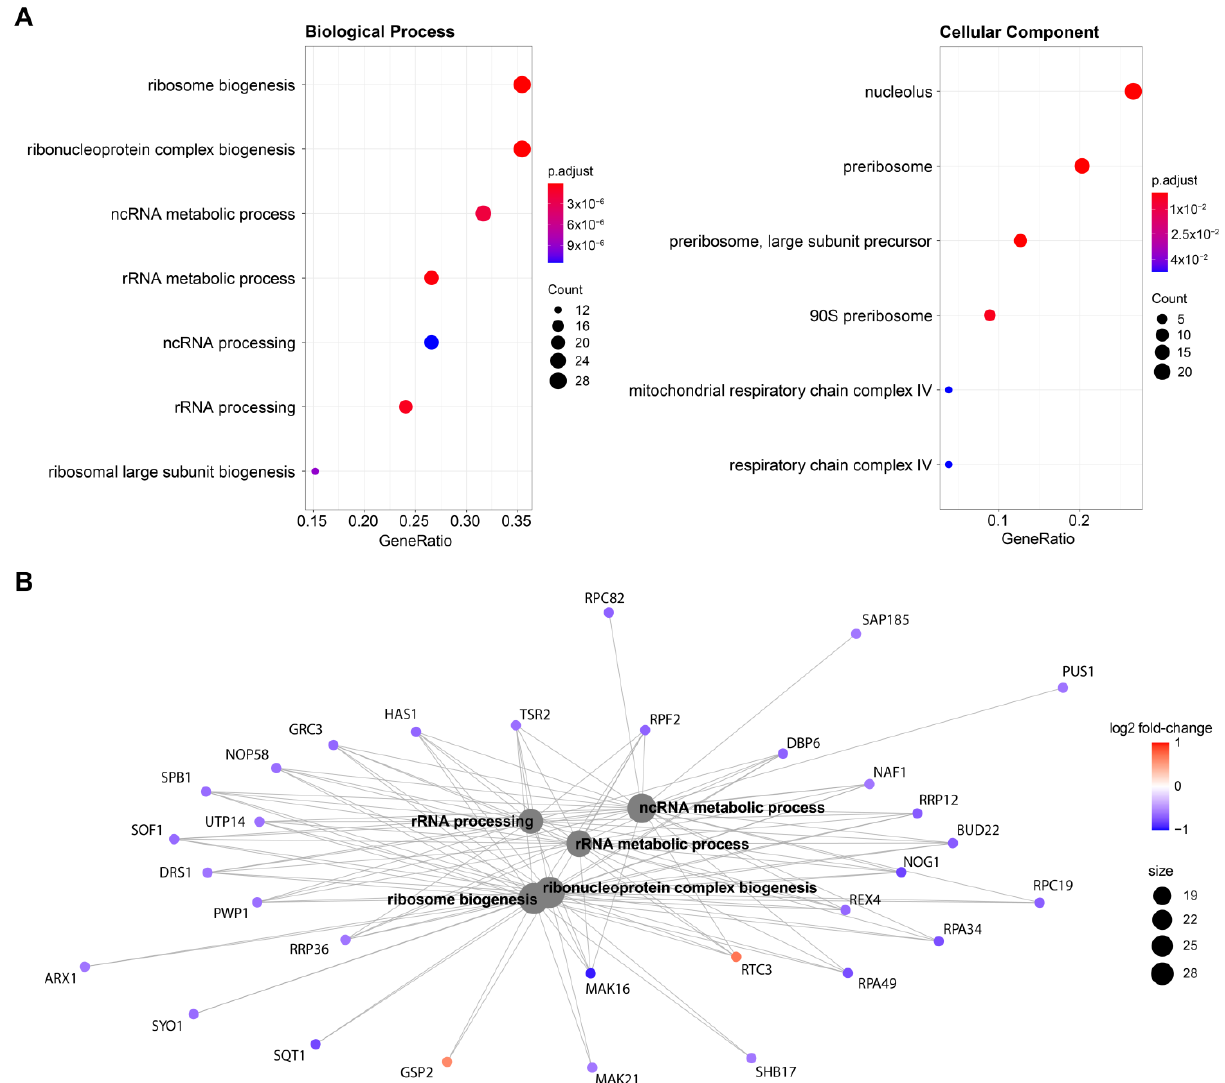
Figure 3. Gene ontology enrichment analysis ( A ) Gene ontology enrichment analysis of the genes significantly modulated by scFv-58F expression. Dot plots depict the main significant terms for the categories “Biological Process” ( left ) and “Cellular Component” ( right ). ( B ) Cnet plot displaying genes involved in the gene-ontology significant terms, with log2 fold-change expression with respect to the control DMSO.